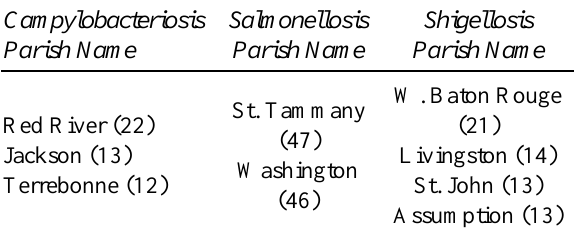
Table 2: Highest number of reported cases of campylobacteriosis, salmonellosis, and shigellosis in Louisiana parishes in 1999 (LDHH